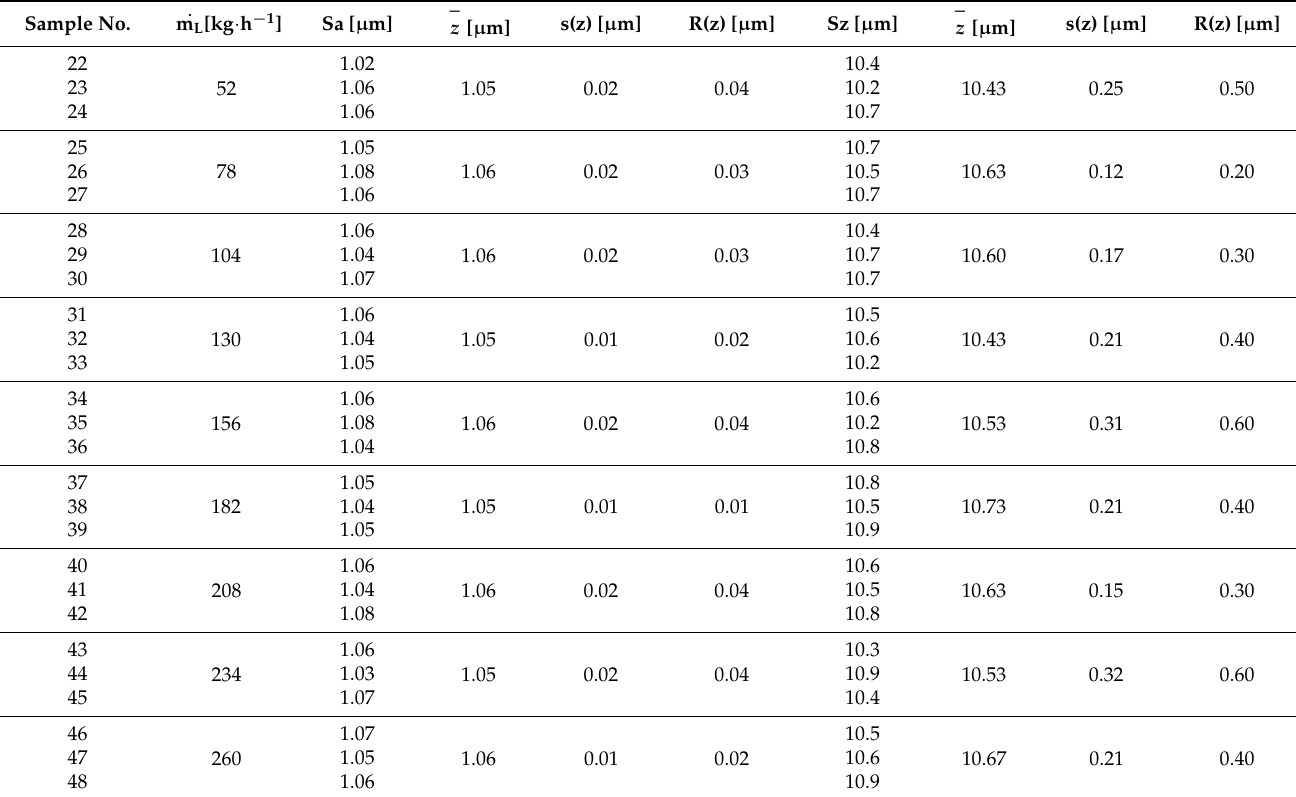
Table 9. Results of Sa and Sz measurements of PA2 aluminum alloy specimens after removal of paint coating (p w = 35 MPa, l 2 = 250 mm, κ = 90 ◦